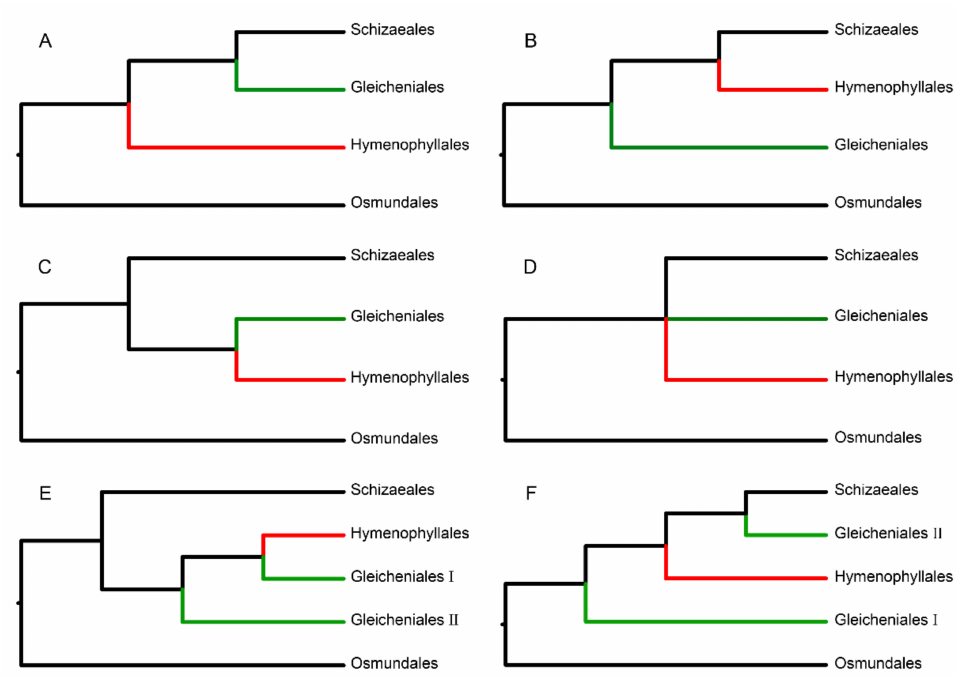
Figure 1. Six topologies of the phylogenetic relationship in the early leptosporangiate ferns. The corresponding references are shown in Table S1. The red branches indicate Hymenophyllales, and the green branches indicate Gleicheniales. Gleicheniales I indicates Gleicheniaceae, and Gleicheniales II indicates Dipteridaceae and